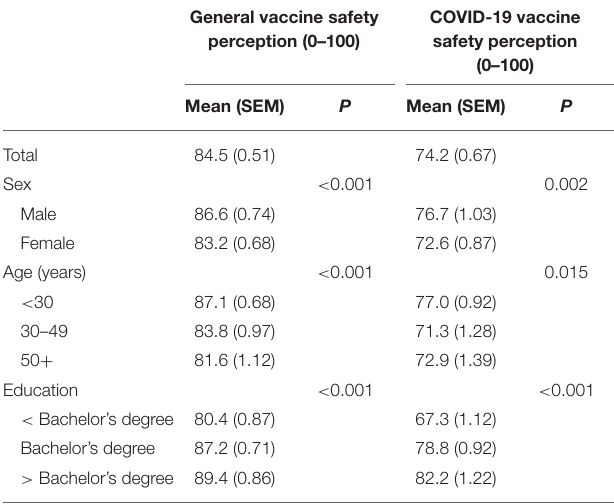
TABLE 3 | Perception of general and COVID-19 vaccine safety among participants ( n = 1,367). Note that COVID-19 vaccines were not differentiated by specific